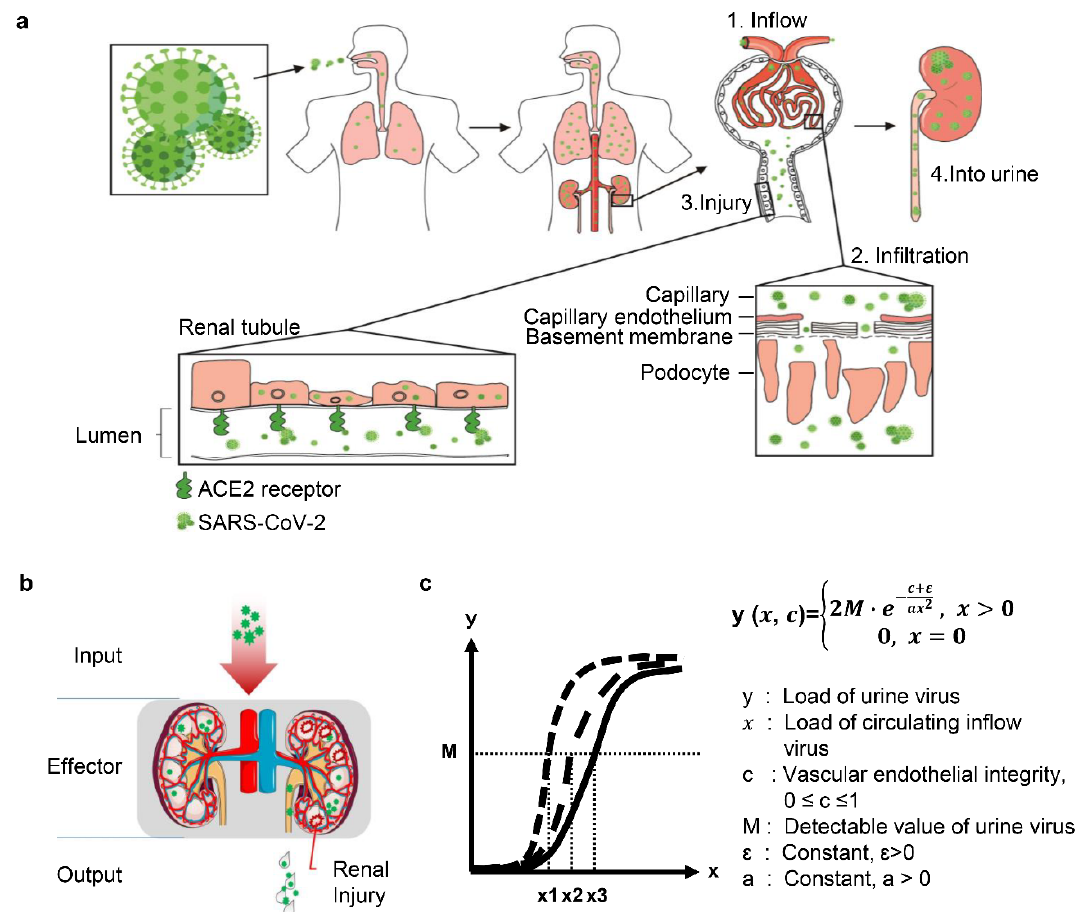
Figure 5. Theoretical and mathematical modeling of the event of urinary SARS-CoV-2 shedding. ( a ) Schematic diagram showed the renal inflow-infiltration-injury-into urine (“4I” model) to illustrate the course and outcome of SARS-CoV-2 infection in kidney. ( b ) Virus excretion can be simplified as a basic effector motif, consisting of input signal (inflow virus), effector (kidney) and output signal (urine shedding). ( c ) Function equation and curve of analytic mathematical model.